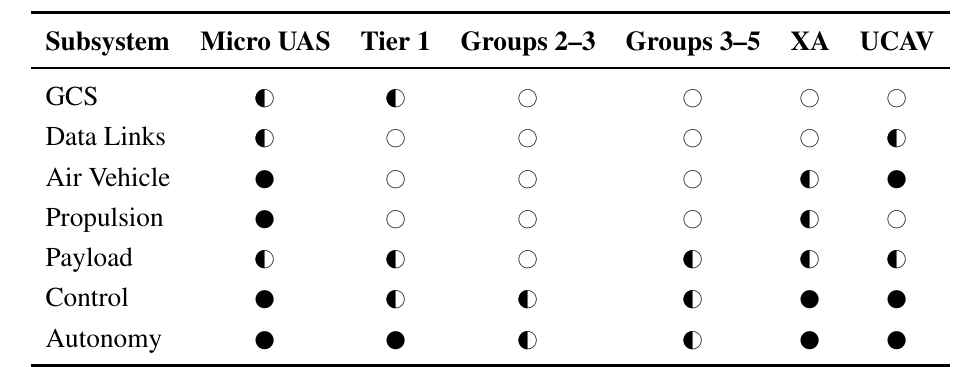
indicates that some specific research is required, (cid:71)(cid:35)